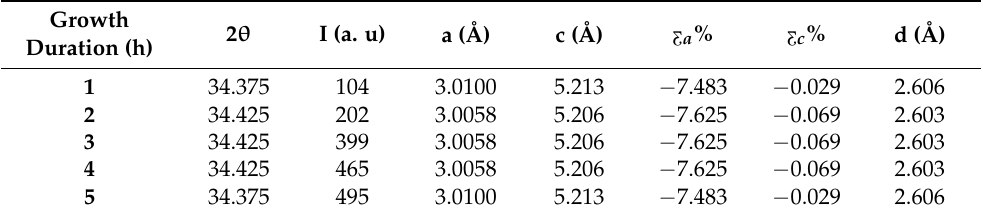
Table 1. Lattice Parameters and Structure Properties of ZnO Nanorods of Diffraction Peak (002) for Different Growth Durations where Air Bubbles Did Not Exist.